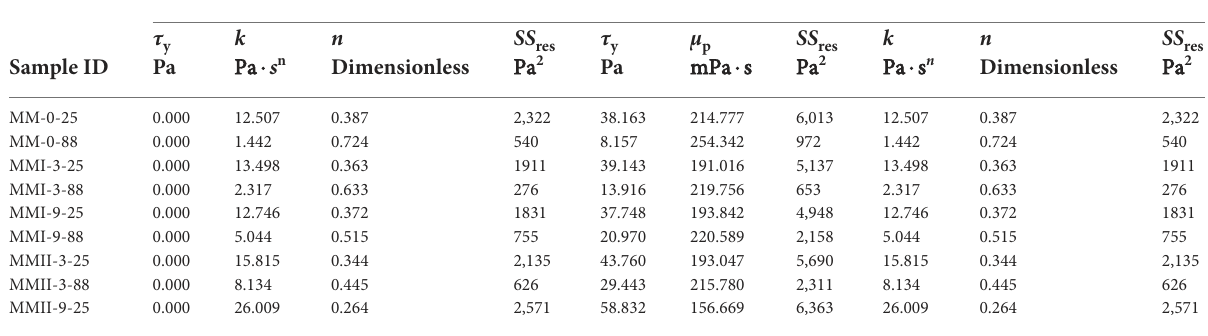
TABLE 5 Parametersofrheologymodelsandtheirresidualerrors.